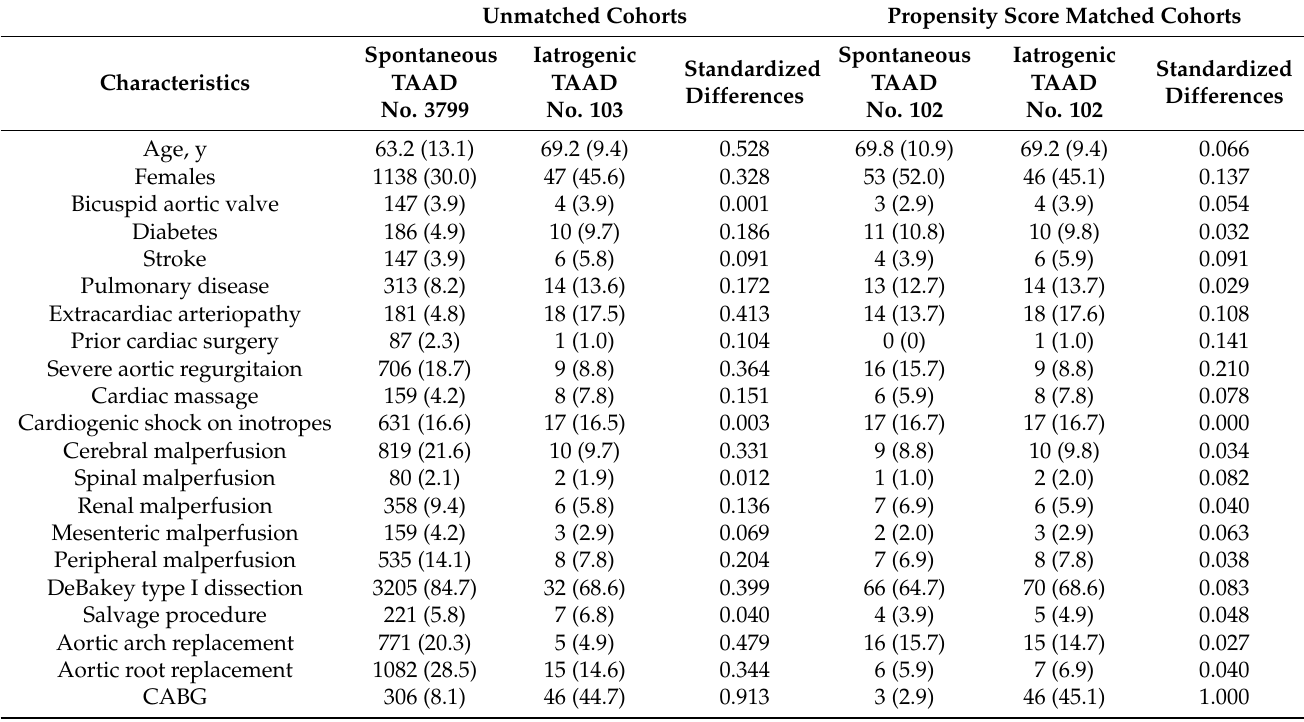
Table 1. Characteristics and operative data of patients with spontaneous and iatrogenic acute TAAD in the unmatched and propensity score matched cohorts.